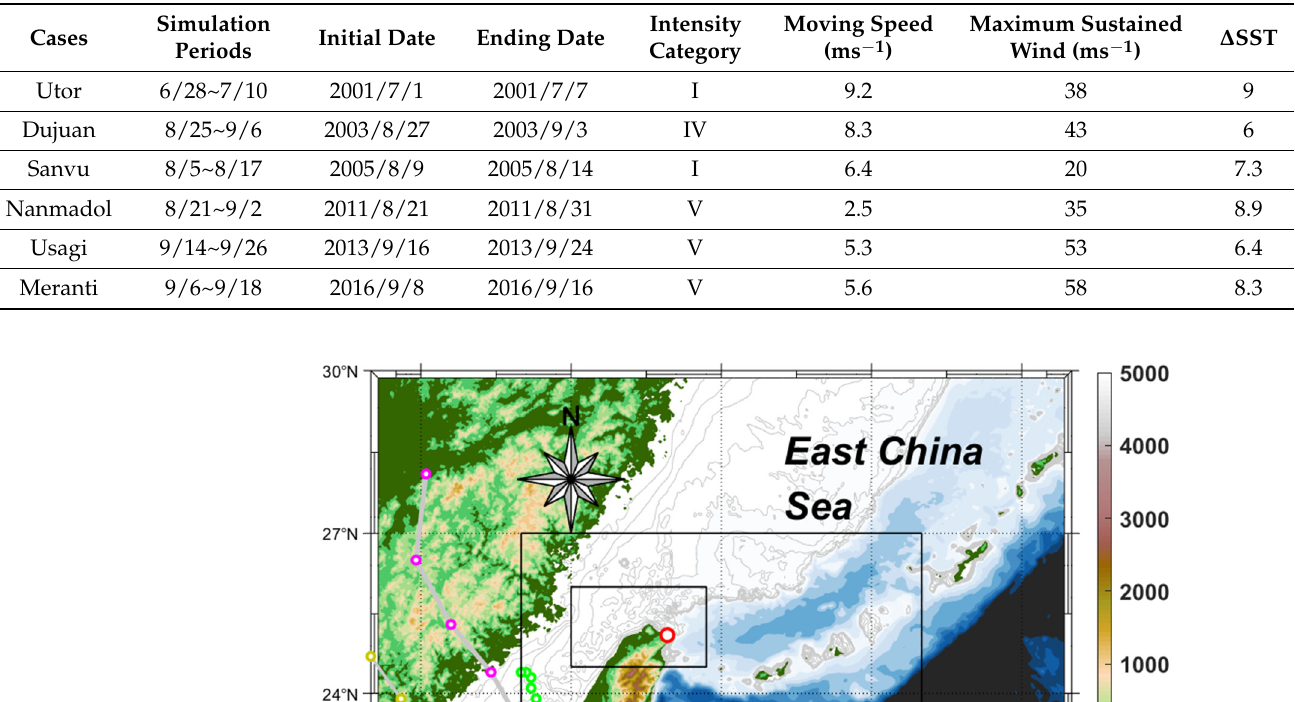
Table 1. Detailed information of 6 typhoon cases and corresponding simulation periods. The initial and ending dates of certain typhoon cases are defined by the first time appearance and final disappearance of TC corresponding to category tropical depression in JTWC.